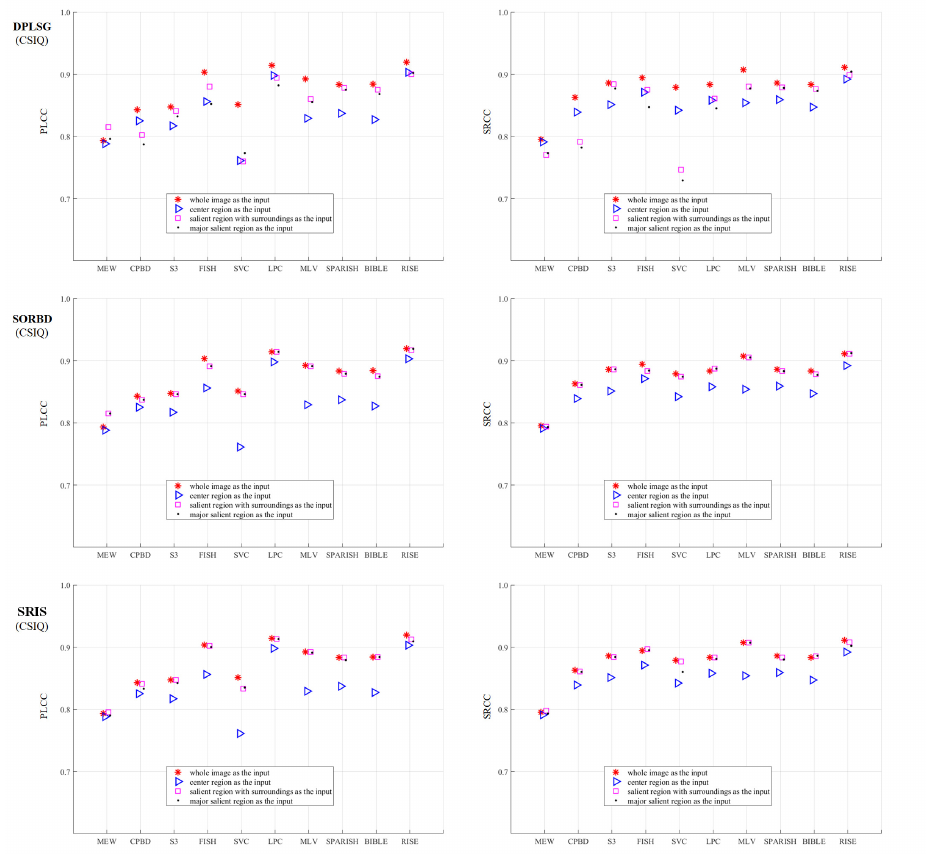
Figure 3. Comparison of prediction scores regarding different inputs on the CSIQ Gaussian blurring images. This indicates that using SR (pink square (cid:3) ) or the mSR (black dot · ) as input could achieve close results to the corresponding WI input (red star ∗ ), and their results are better than that using the CR (blue triangle (cid:52) ) input. (The figure can be enlarged for